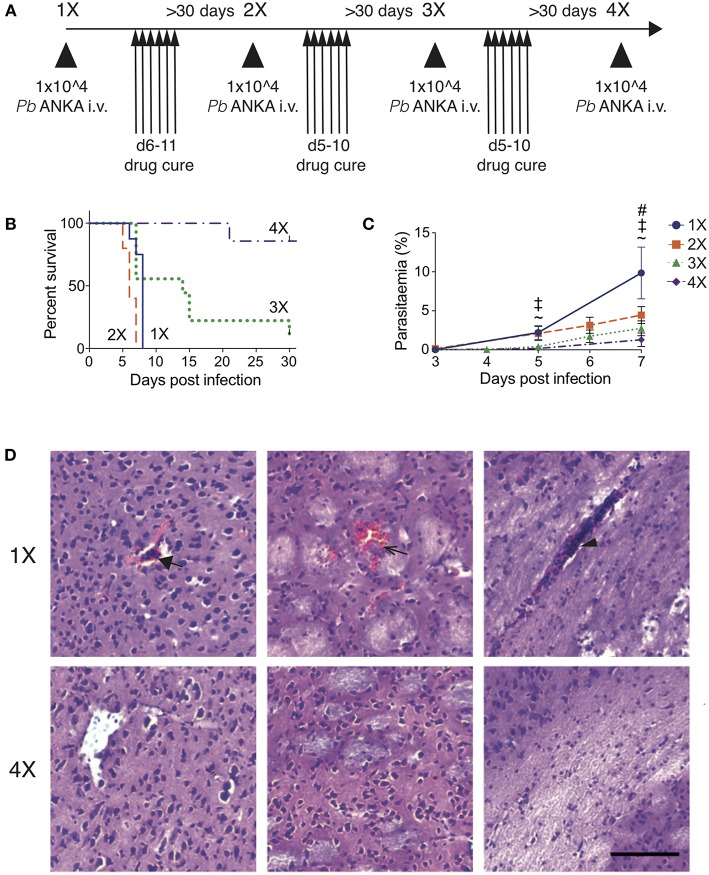
Three rounds of infection-drug cure promote resistance to ECM in susceptible C57BL/6 mice. (A) Schematic of the experimental design. C57BL/6 mice were infected with PbA (104 pRBCs i.v.) or left uninfected. Mice were treated (i.p.) with chloroquine and artesunate on stated days post each infection, and re-infections were performed after a minimum interval of 30 days following cessation of drug treatment. (B) Kinetics of ECM development shown as percentage of survival of mice. N = 7–10 per group, pooled from two independent experiments. (C) Peripheral parasitaemia (% of pRBCs) ± SD in different infection groups. N = 5–9 per group. Results are pooled from two experiments for the 1X, 2X, and 3X infection and from 3 experiments for the 4X infection. Kruskal-Wallis test with Dunn's multiple comparisons test was used for statistical analysis p < 0.05 denoted by #, for 1X v 3X, ‡ for 1X v 4X, and ~ for 2X v 4X. (D) Representative H & E stained cortical brain sections demonstrating presence (in 1X infected mice) and absence (in 4X infected mice) of cerebrovascular pRBCs (filled arrow), hemorrhage (unfilled arrow) and leukocyte packed vessels (arrow head) in 1 and 4X infected mice on day 8 post infection. Scale bar 100 μm.